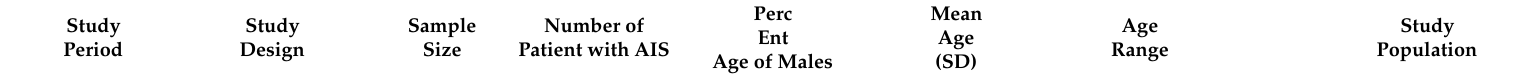
Table 1. Demographic characteristics of the included